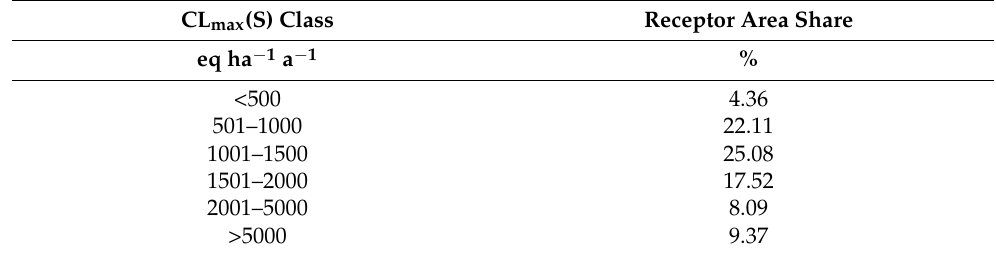
Table 23. Share of receptor areas in Germany in the classes of critical loads for acidifying sulphur inputs.